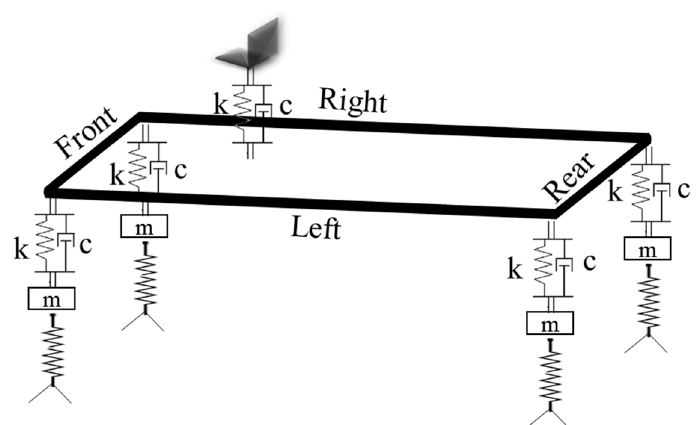
Figure 13. Integrated seat and suspension model [96].